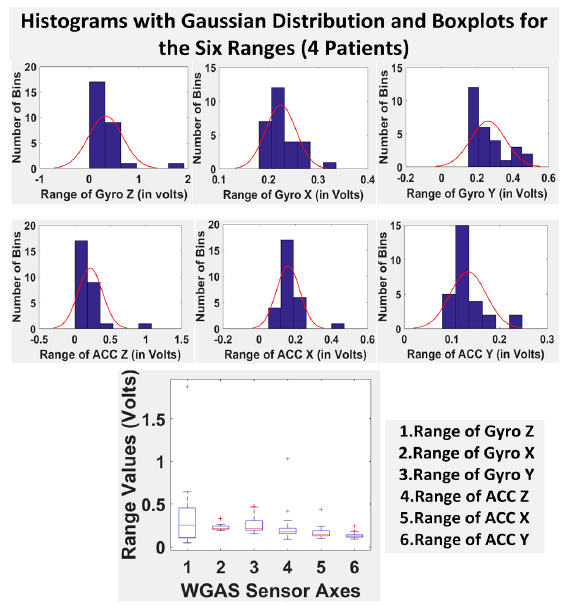
Figure 8. Histograms with the Gaussian distribution and box plots for the six ranges combining all of the DGI tests from the four patients.